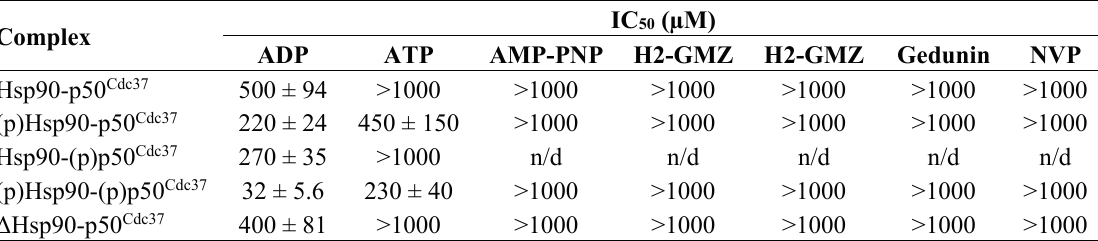
Table 2. Disruptive potential of small molecules against Hsp90 β -p50 Cdc37 complexes determined by